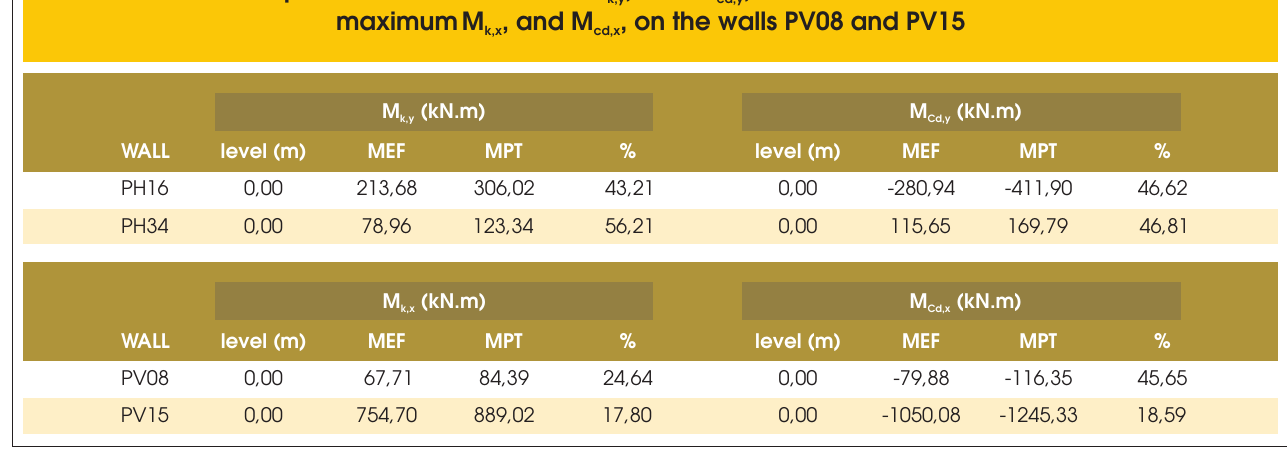
Table 5 – Comparison of the maximum M , and M , on the walls PH16 and PH34 and the